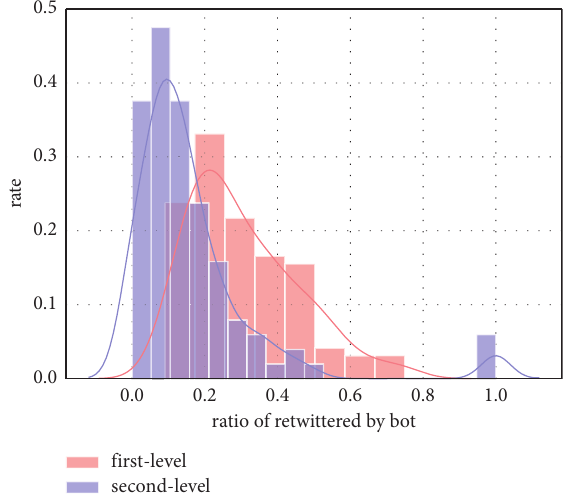
Figure 2: Distribution of the contribution of bots in primary and secondary communication for 121 New York Times stories in- volving the border.